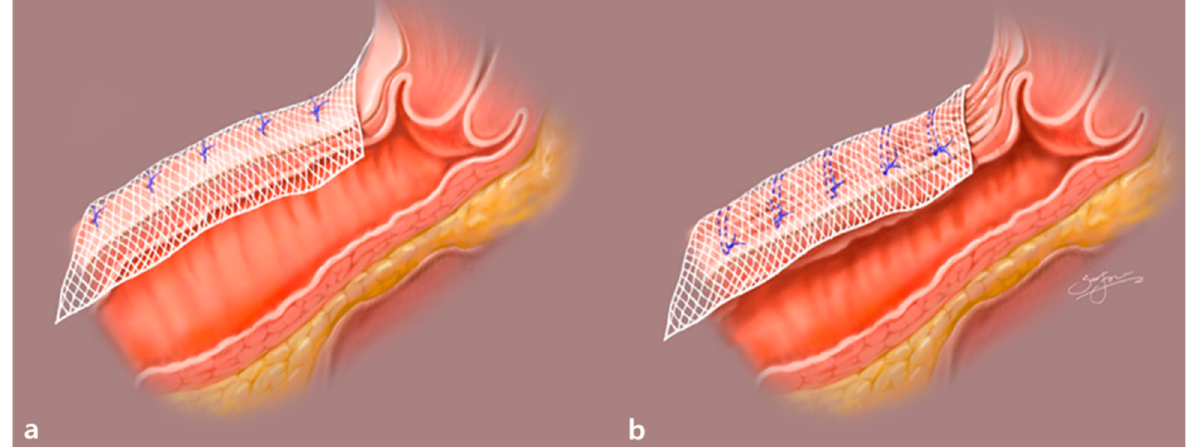
Figure 2. Comparison of the two surgical methods of mesh attachment during sacrocolpopexy. ( a ) The conventional, non-wrinkle method. ( b ) The wrinkle method. The wrinkle method can narrow the caliber of the vaginal canal, thicken the anterior vaginal wall, and broaden the anterior vaginal wall surface covered by the same amount of mesh.